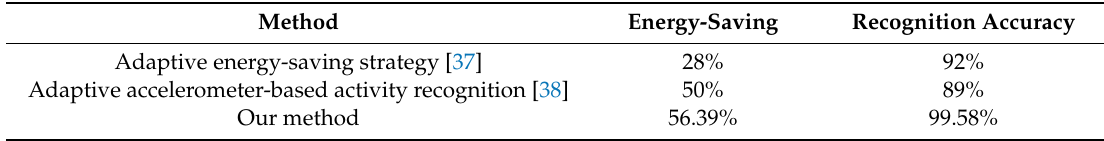
Table 8. Comparison with di ff erent